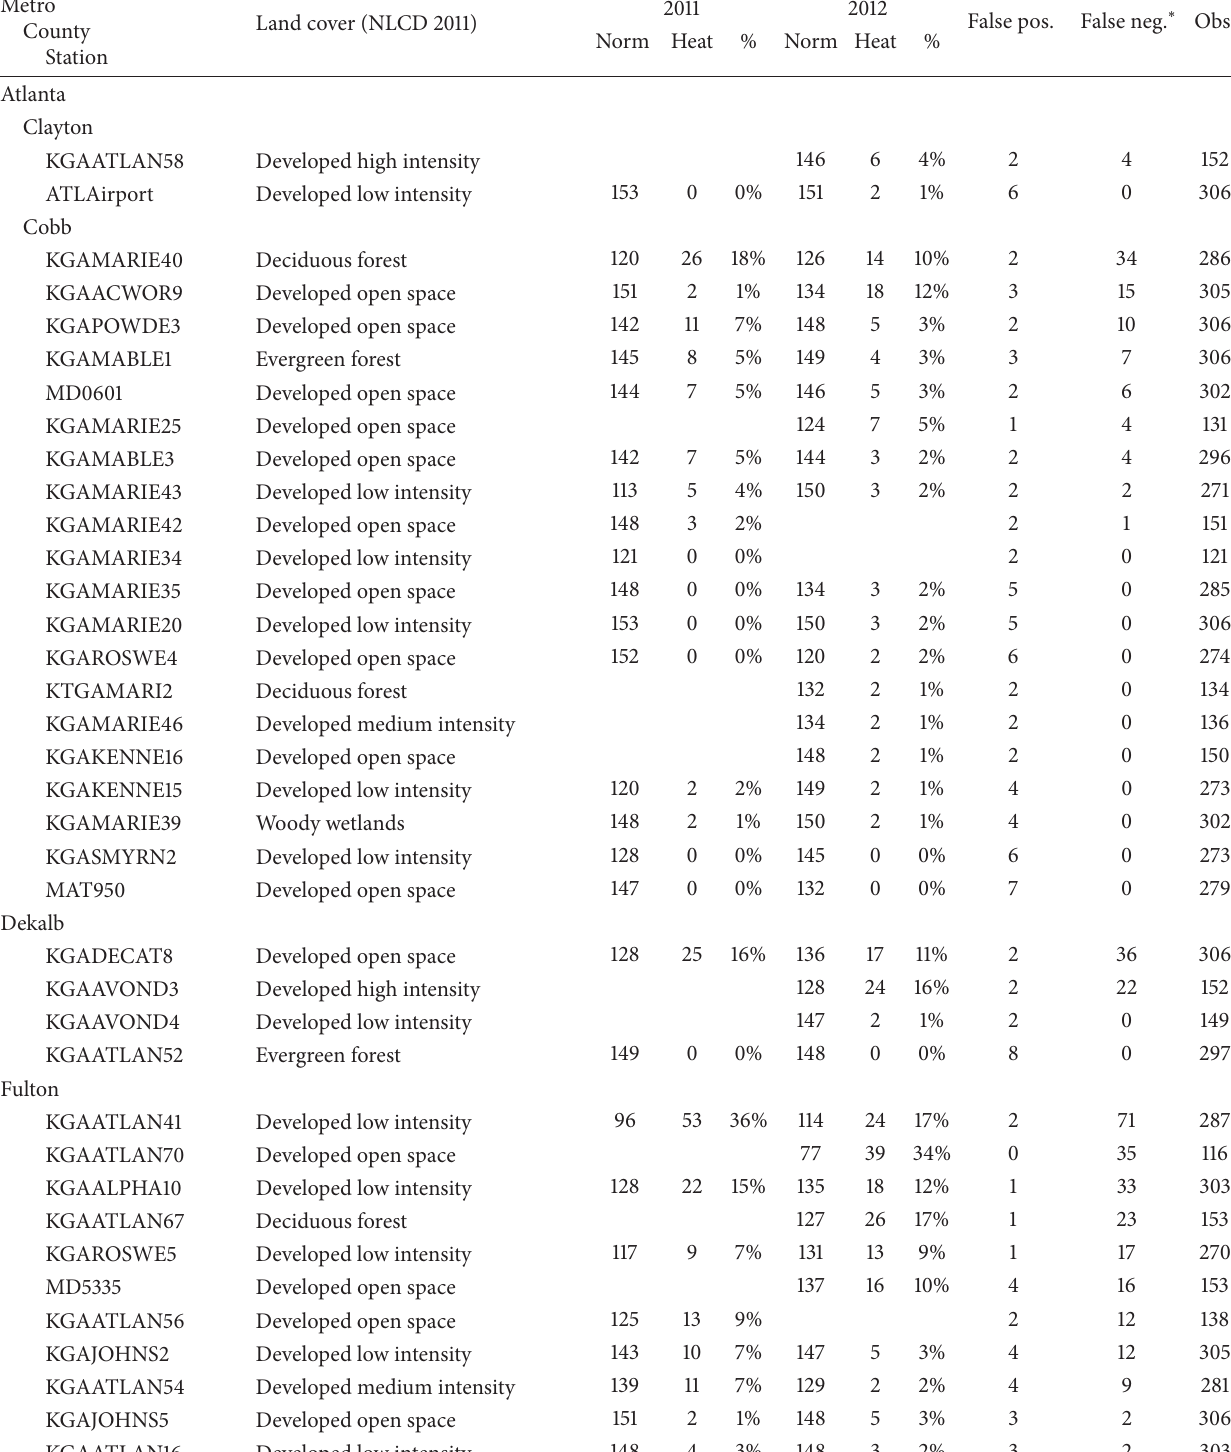
Table 1: Atlanta weather station details on the number of normal (“Norm”) and Advisory (“Heat”) days during the summer of 2011 and 2012. The total number of false positives (no station hazard with NWS advisory) and false negatives (station hazard with no NWS Advisory) is also provided to give an idea of the agreement between the station and the NWS Advisories for that